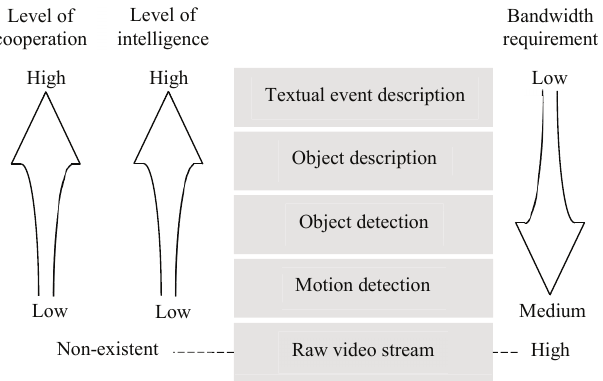
Figure 2. Local Processing in